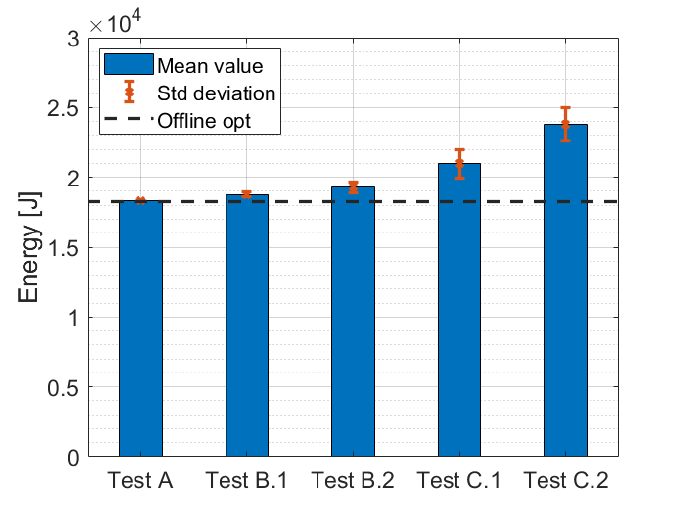
Figure 11. Experimental test results: energy consumption mean values and standard deviations. Direct comparison of the results between the different cases tested is shown in Table 4.